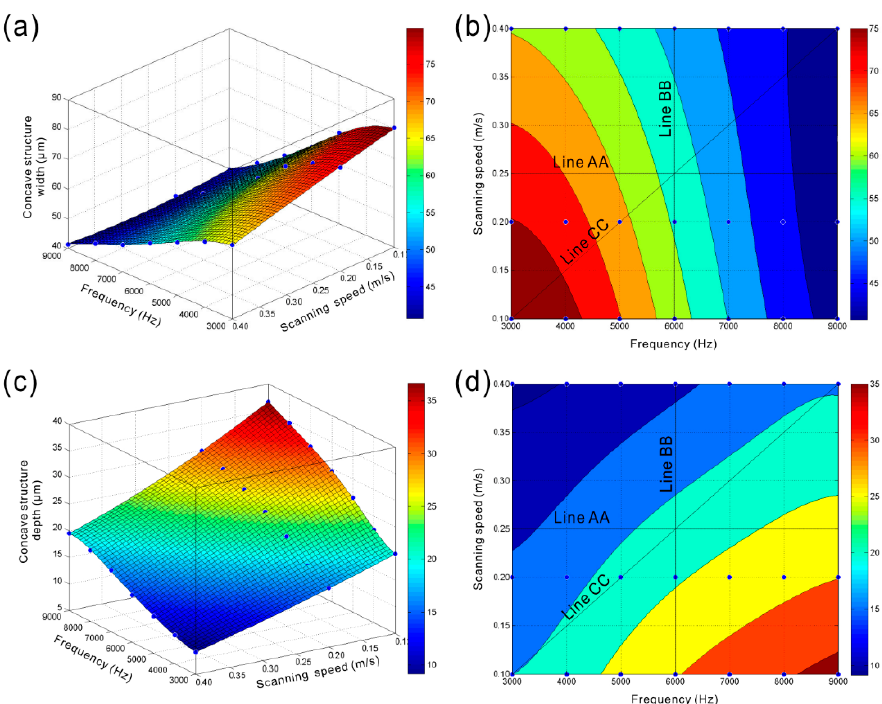
Figure 12. ( a , b ) Variations of concave structure width of the strip microstructure with laser beam pulse frequency and scanning speed; ( c , d ) Variations of depth of concave structure of the strip microstructure with laser beam pulse frequency and scanning speed.